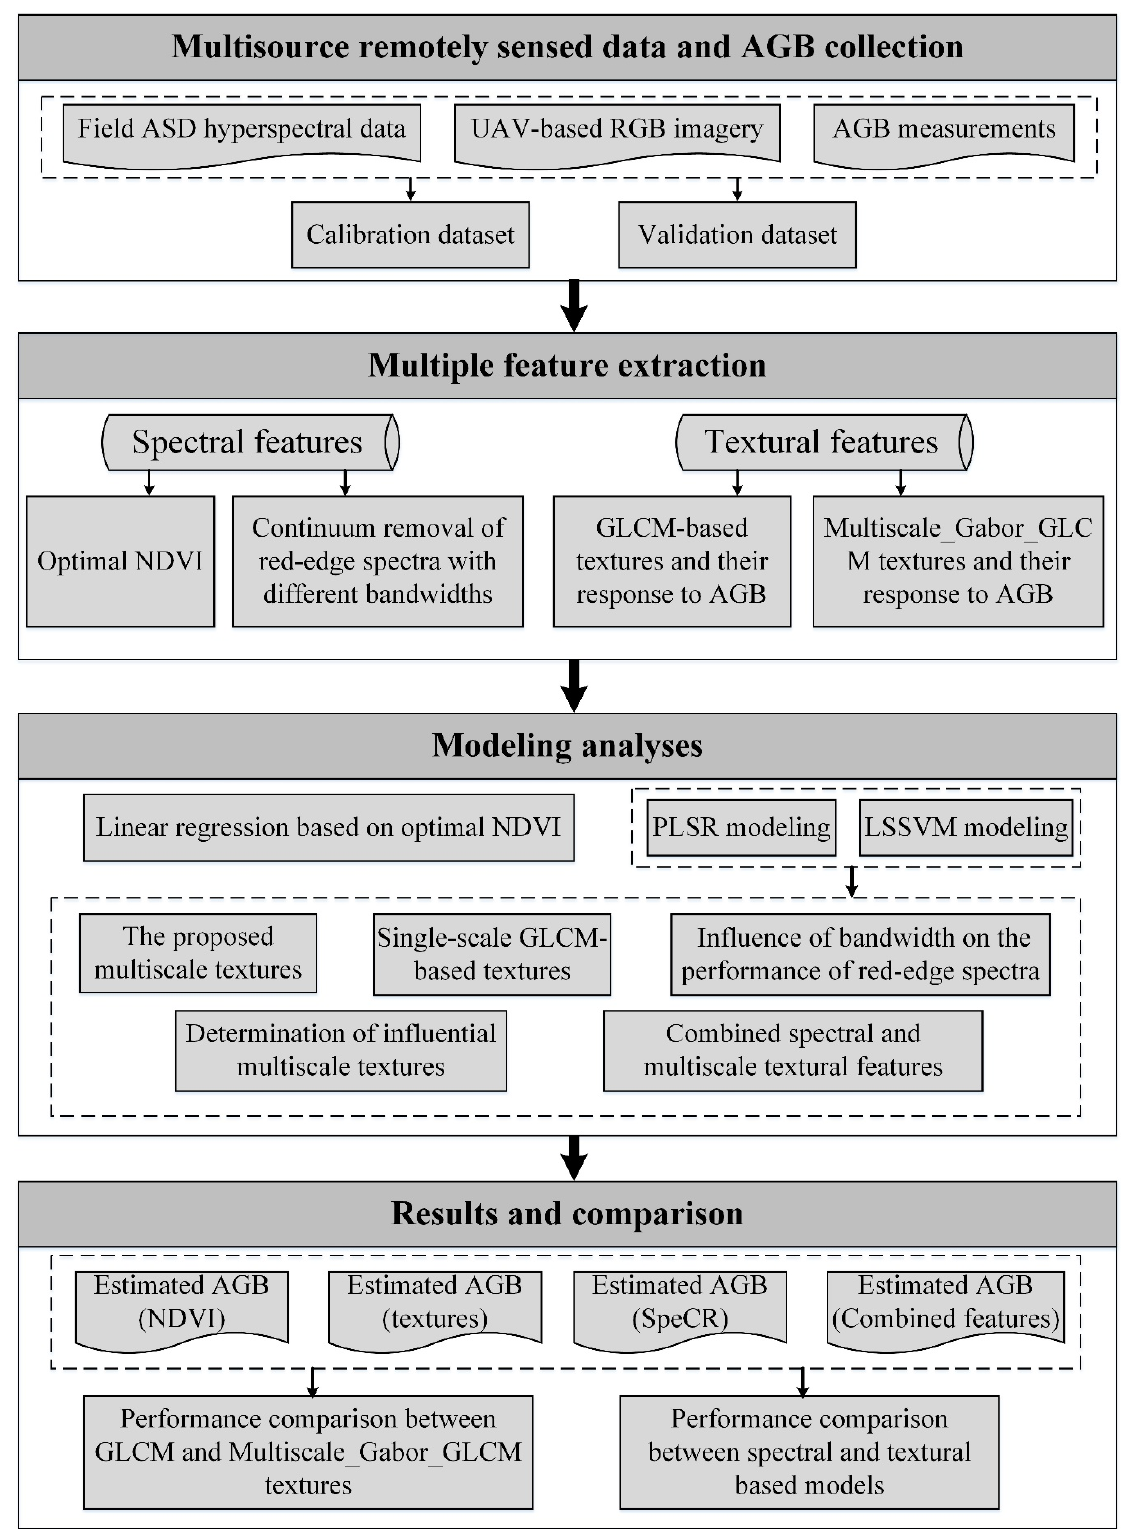
Figure 2. Modeling framework and comparison analyses of the study.